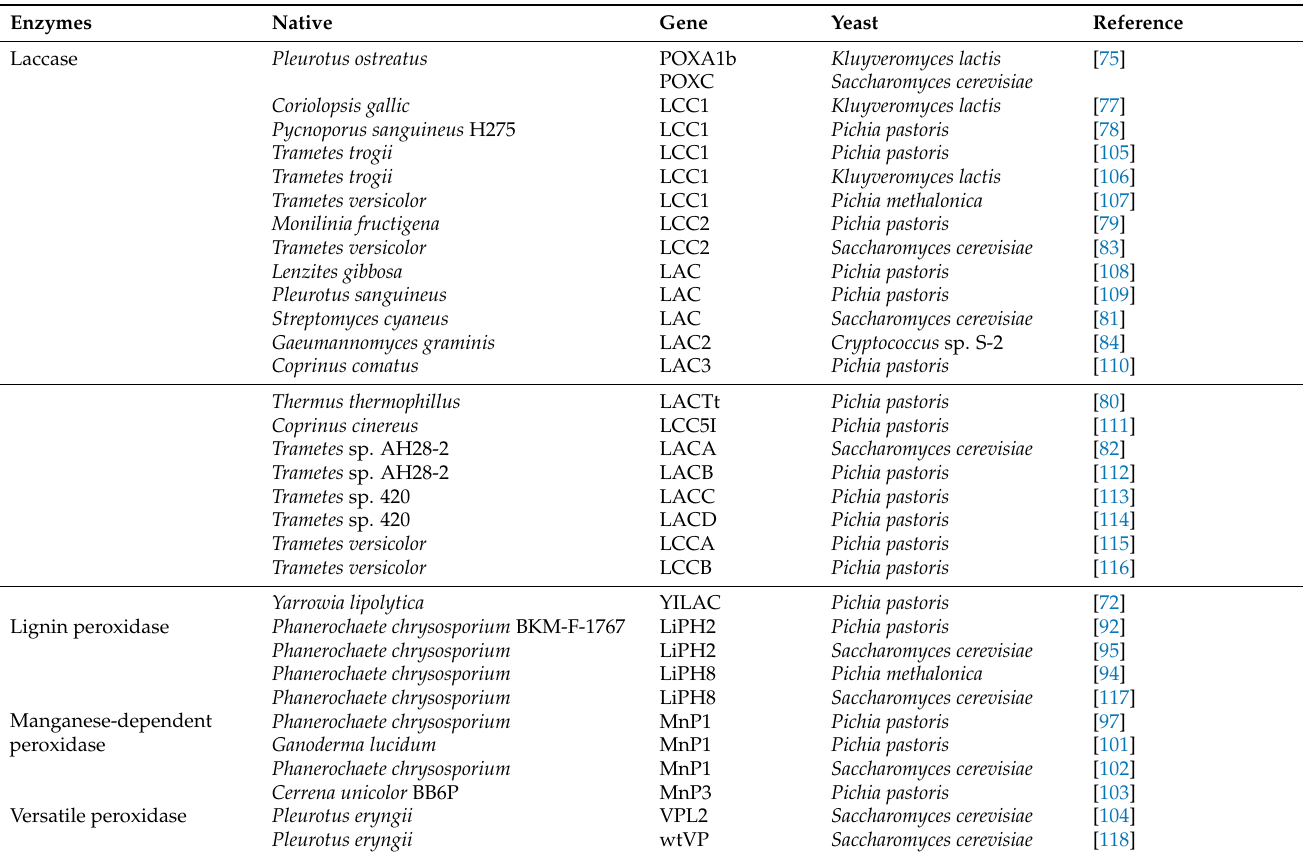
Table 2. Lignin-degrading enzymes produced by